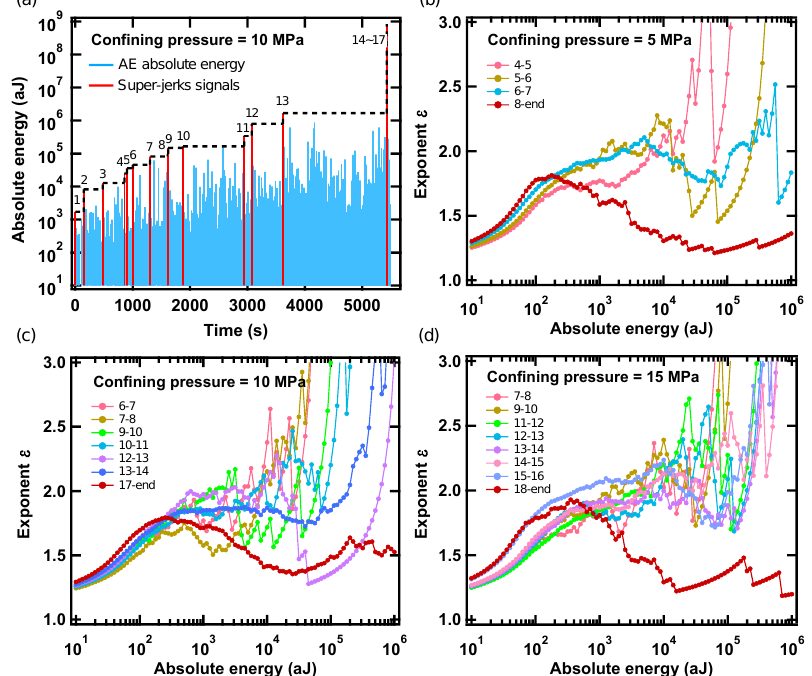
Figure 3. ( a ) Time sequence of jerk events under confined stress compression. The blue jerks are the AE energy spectrum, and red jerks are superjerks as record-breaking events. Superjerks are more energetic than any of the previous jerks (1 aJ = 10 − 18 J). ( b – d ) Energy exponent ε as function of the lower energy cutoff is determined by maximum likelihood (ML) for k intervals under different confinement levels.